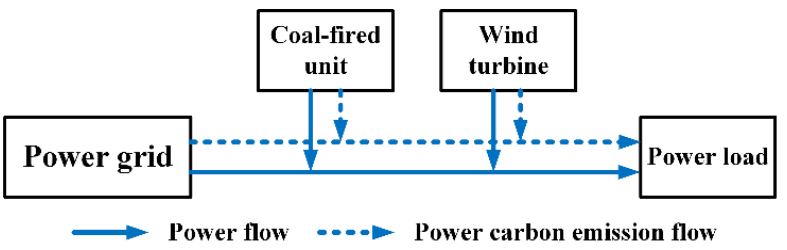
Figure 1. Schematic of the power flow and carbon emission flow.